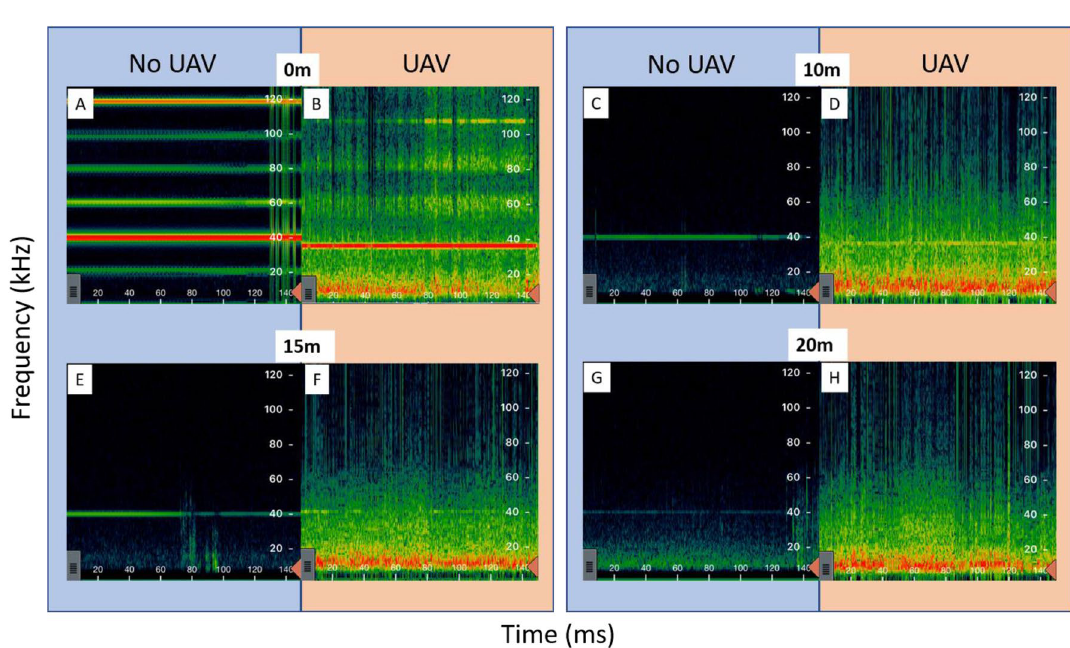
Figure 4. Visual comparison of signal detection range with ambient noise and UAV noise interference. Shading represents noise amplitude from low (green) to high (red). Panels inside the blue zones ( A , C , E , G ) represent samples taken under ambient noise interference, while panels inside the red zones ( B , D , F , H ) represent samples with UAV noise interference. Distance indicators represent the distance of the detector from the loudspeaker broadcasting ultrasounds. Bats present in our study area had calls typically between 25 and 80